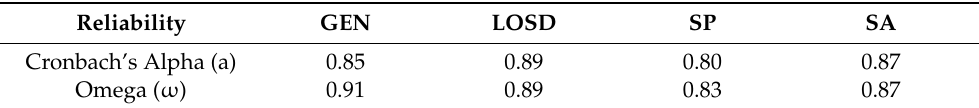
Table 5. The Gratitude Resentment and Appreciation Test-Revised Short (GRAT-RS): indexes of reliability ( n = 537). Reliability GEN LOSD SP SA Cronbach’s Alpha (a) 0.85 0.89 0.80 0.87 Omega ( ω ) 0.91 0.89 0.83